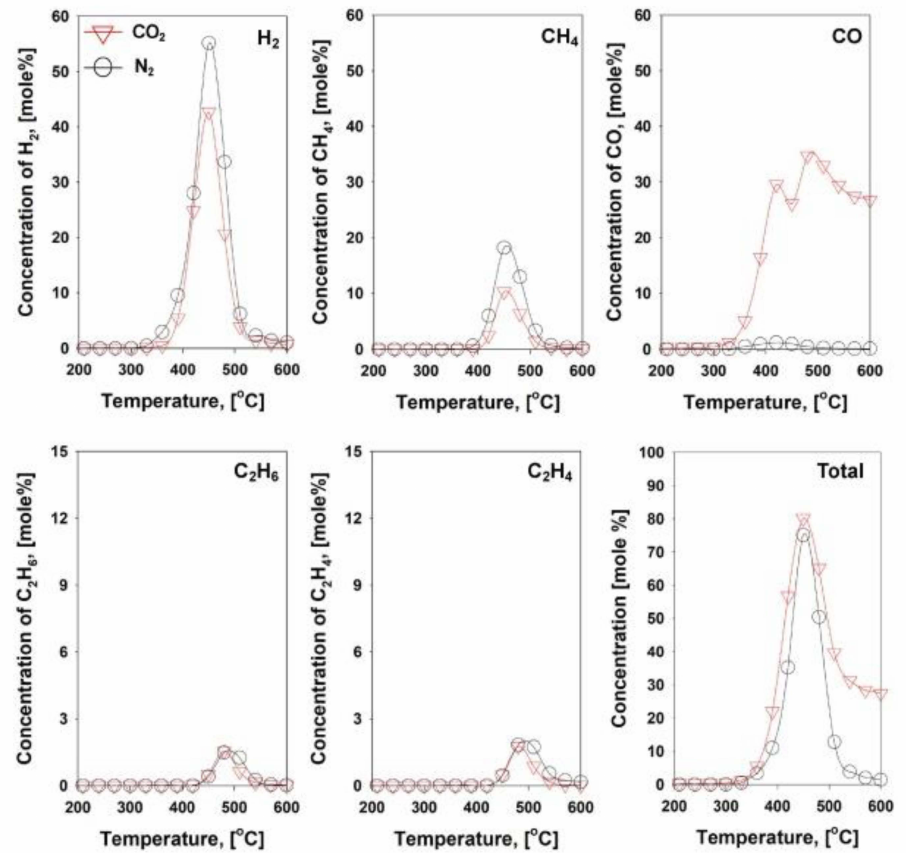
Figure 9. Producing concentrations of syngas and C 1–2 hydrocarbons from the Ni/SiO 2 -catalyzed mask pyrolysis under the carrier gases N 2 and CO 2 . Reproduced with permission from Ref.